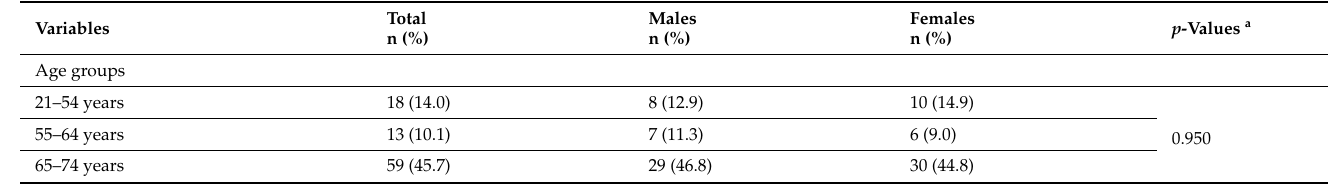
Table 1. Sociodemographic data, risk factors, and comorbidities of the study population. Legend: * Asterisked data indicate statistically significant